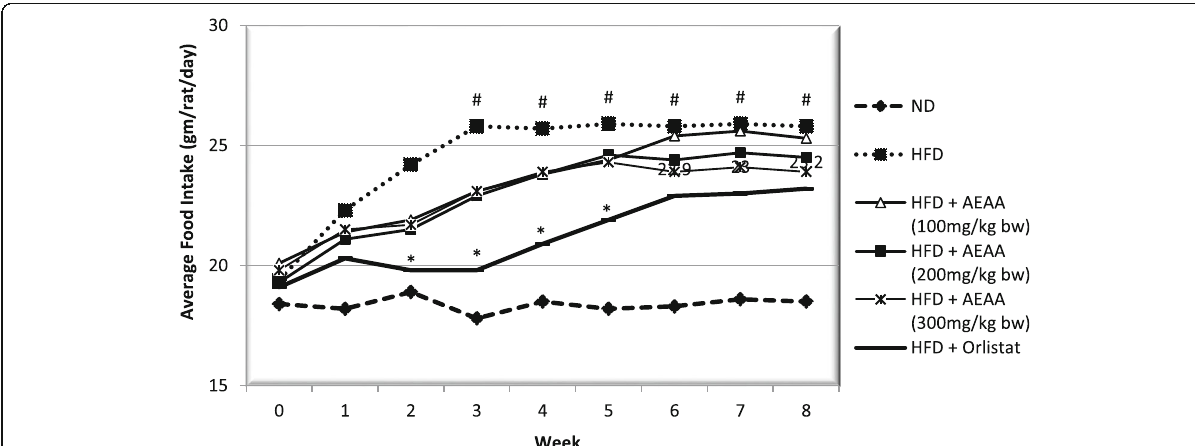
Fig. 4 Levels of Daily Food Intake in experimental rats; values are mean of 6 rats; # p < 0.05, significantly different from ND fed group; *p < 0.05, significantly different from HFD administered group; AEAA – Aqueous Extract of Achyranthes aspera L.; ND – Normal Diet; HFD – High Fat